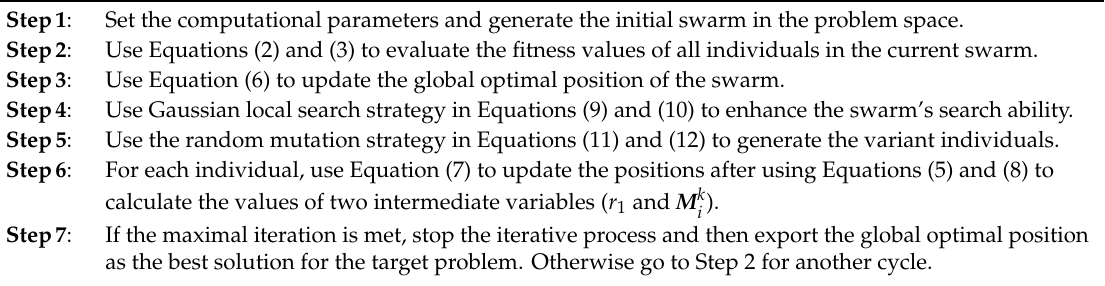
Table 2. Details of the benchmark functions.